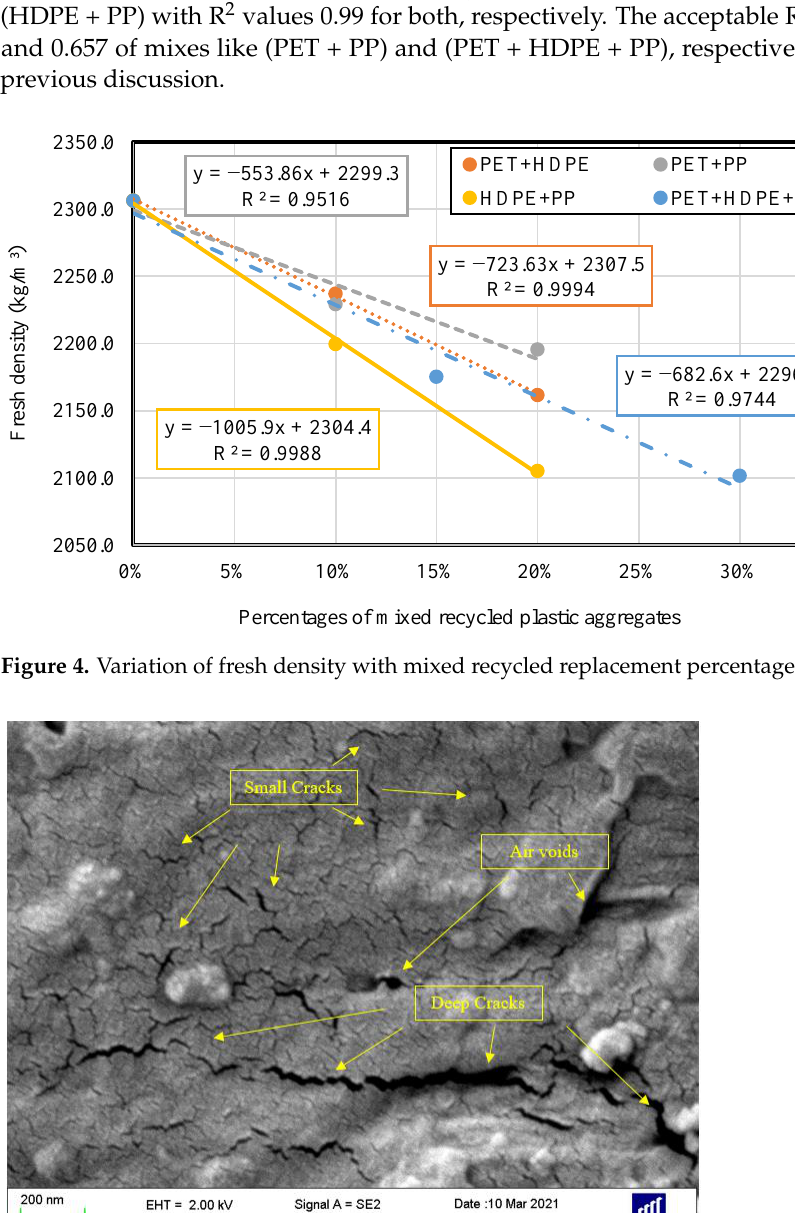
Table 2. Physical properties of fresh concrete and hardened density at 28 days.